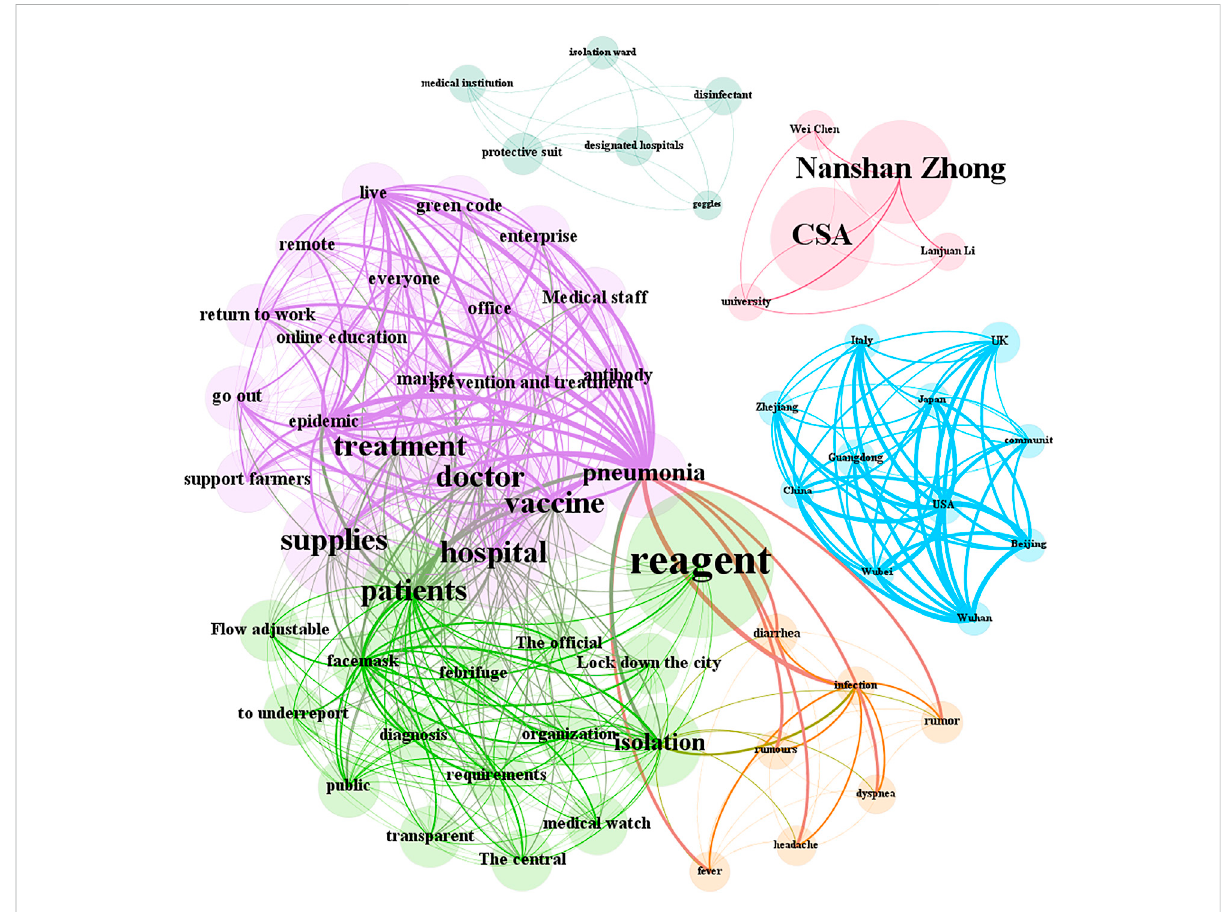
FIGURE 8 Knowledge map of main keywords in each